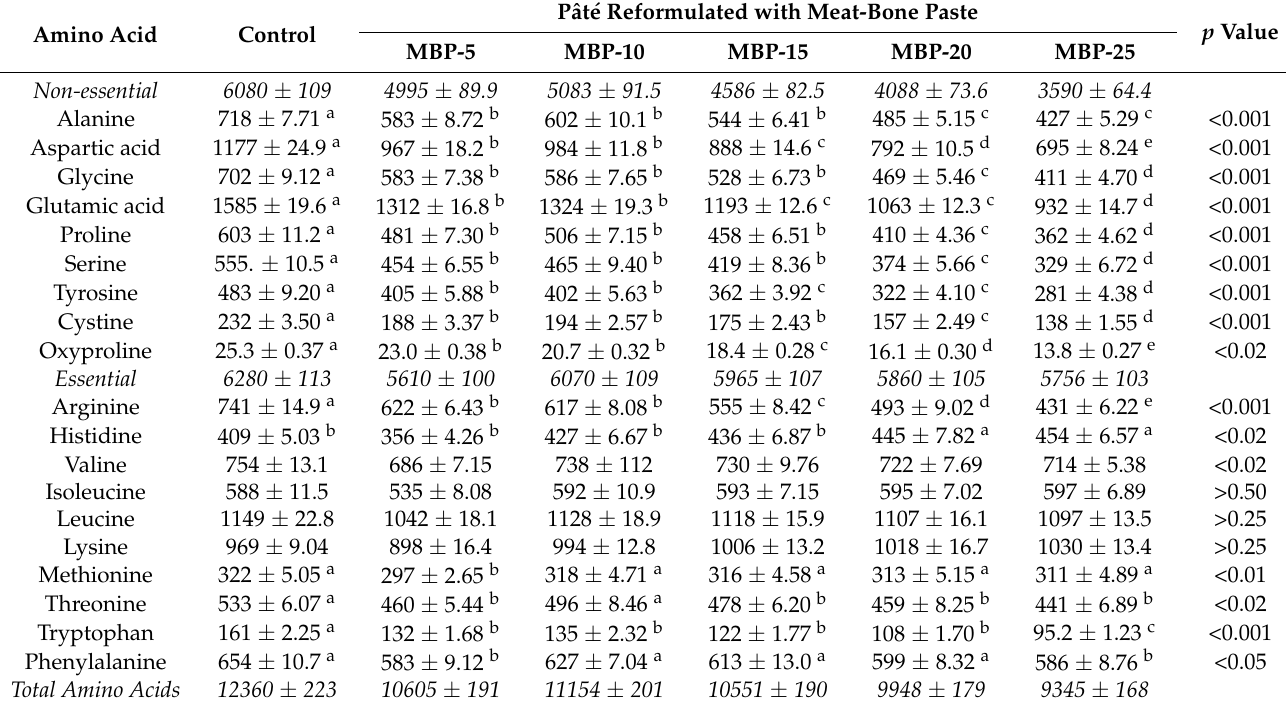
Table 7. Amino acid composition (expressed as mg/100 g) of liver p â t é